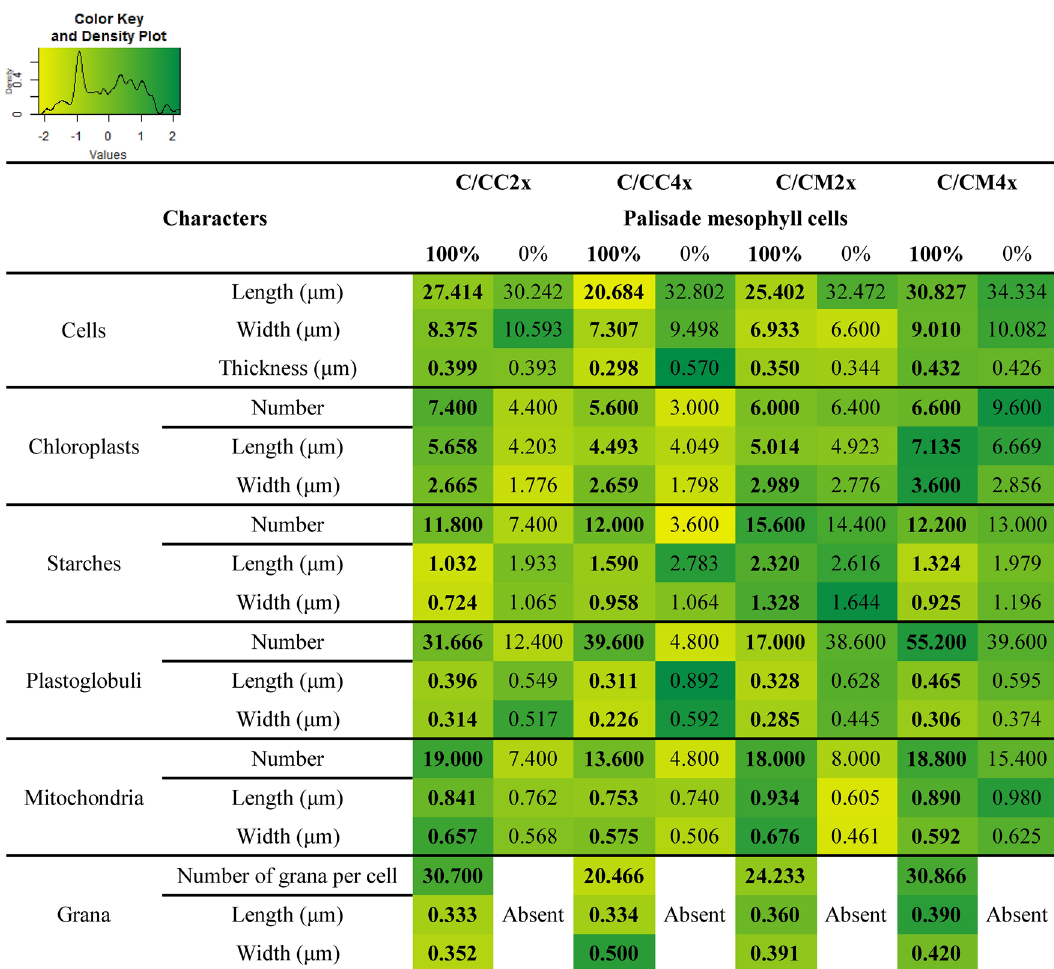
Table 3. Ultrastructure of palisade mesophyll cells of leaves of common clementine scion grafted onto different rootstocks. Ultrastructure characters of palisade mesophyll cells of leaves of common clementine scion grafted onto diploid (C/CC2x) and doubled diploid (C/CC4x) Carrizo citrange and diploid (C/CM2x) and doubled diploid (C/CM4x) Citrumelo 4475 rootstocks grown in nutrient reference solution (100%) and without nutrient solution (0%) for 210 days. Values are means (± standard error) of independent measurements on five different cells section ( n = 5) for length, width and thickness of cells and for number of chloroplasts, starches, plastoglobuli and mitochondria and of 30 independent measurements on different cells section ( n = 30) for length and width of chloroplasts, starches, plastoglobuli, mitochondria, grana, number of grana per cells section and number of thylakoids per granum. The heatmap shows the differences between the four scion/rootstocks combinations and treatments for each characteristic. Values are associated with color ranging from yellow (low) to dark green